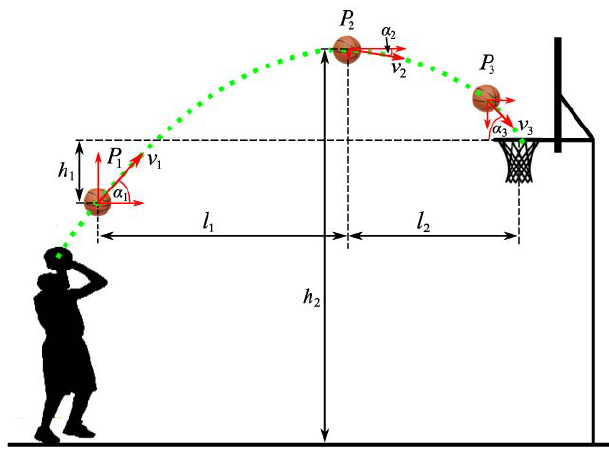
Fig. 4 Parabolic trajectories at different shooting